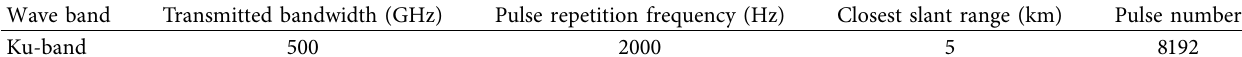
Figure 9: Two-dimensional IRFs of the reflector in Scene 3. (a) Range IRF. (b) Azimuth IRF. Table 2: Main parameters of the SAR system.